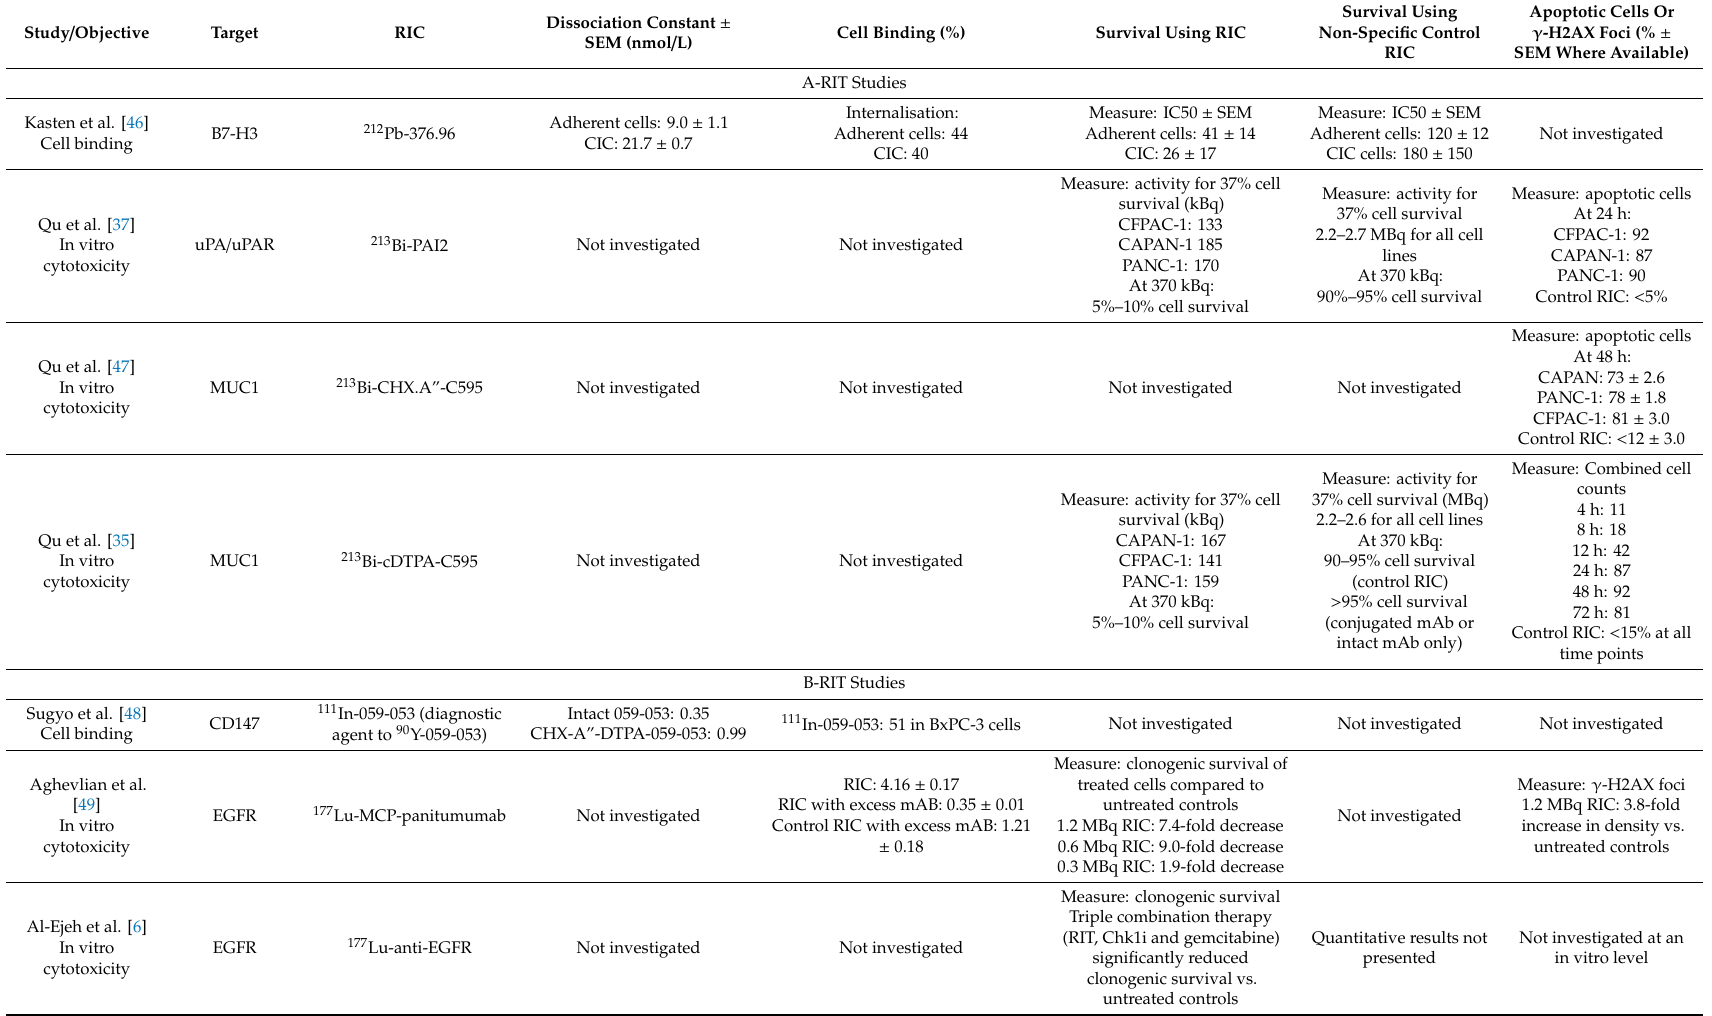
Table 3. Summary of the in vitro studies investigating α and β RIT approaches for the treatment of